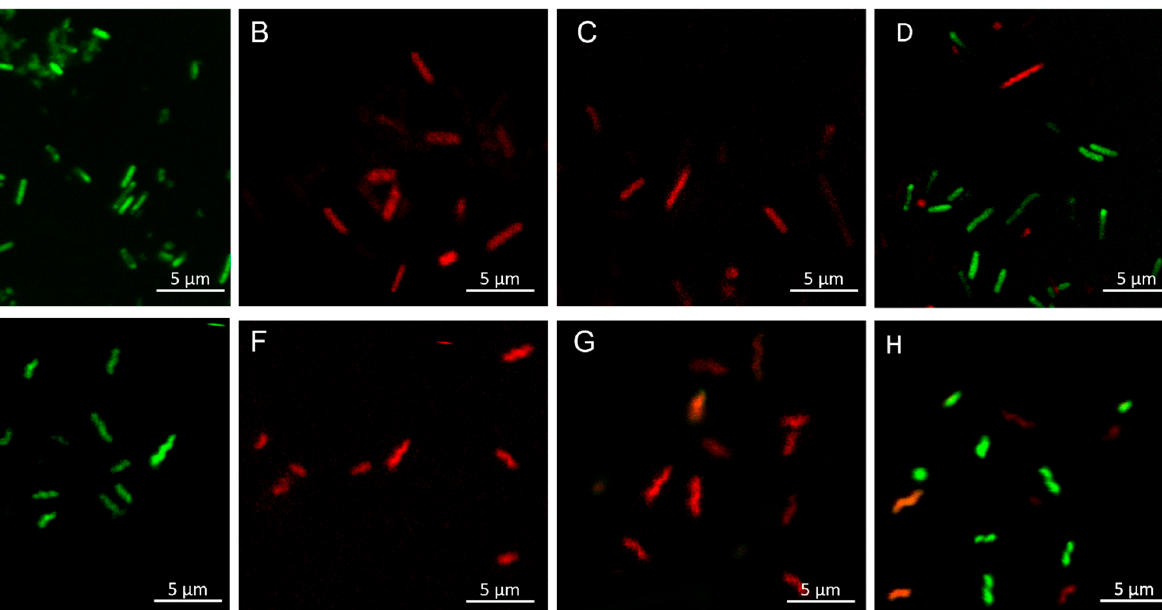
Figure 4. Reduction of Campylobacter jejuni ATCC 33560 with treatments with metal-oxide chitosan films after 24 h incubation. The value from control group (CS) was set as 100%. Statistical significance is marked in relation to the chitosan nanocomposite (CS) ( n = 6, * p < 0.05, *** p < 0.001).